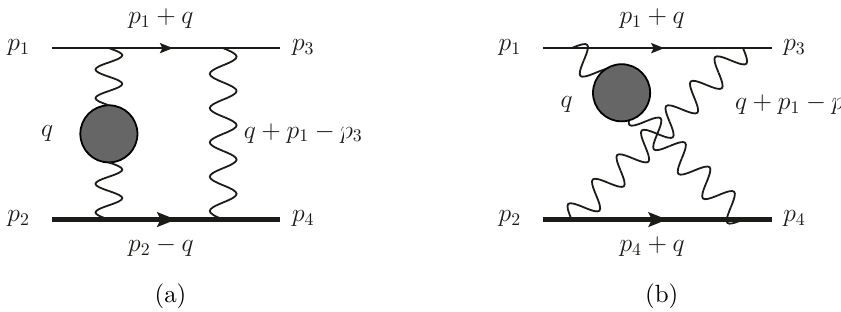
Figure 4. Irreducible hadronic box diagrams contributing to (cid:22) - e scattering at NNLO. Muon and electron lines are depicted with thick and thin lines. Two additional diagrams, with the vacuum polarization in the other photon propagator, must be considered